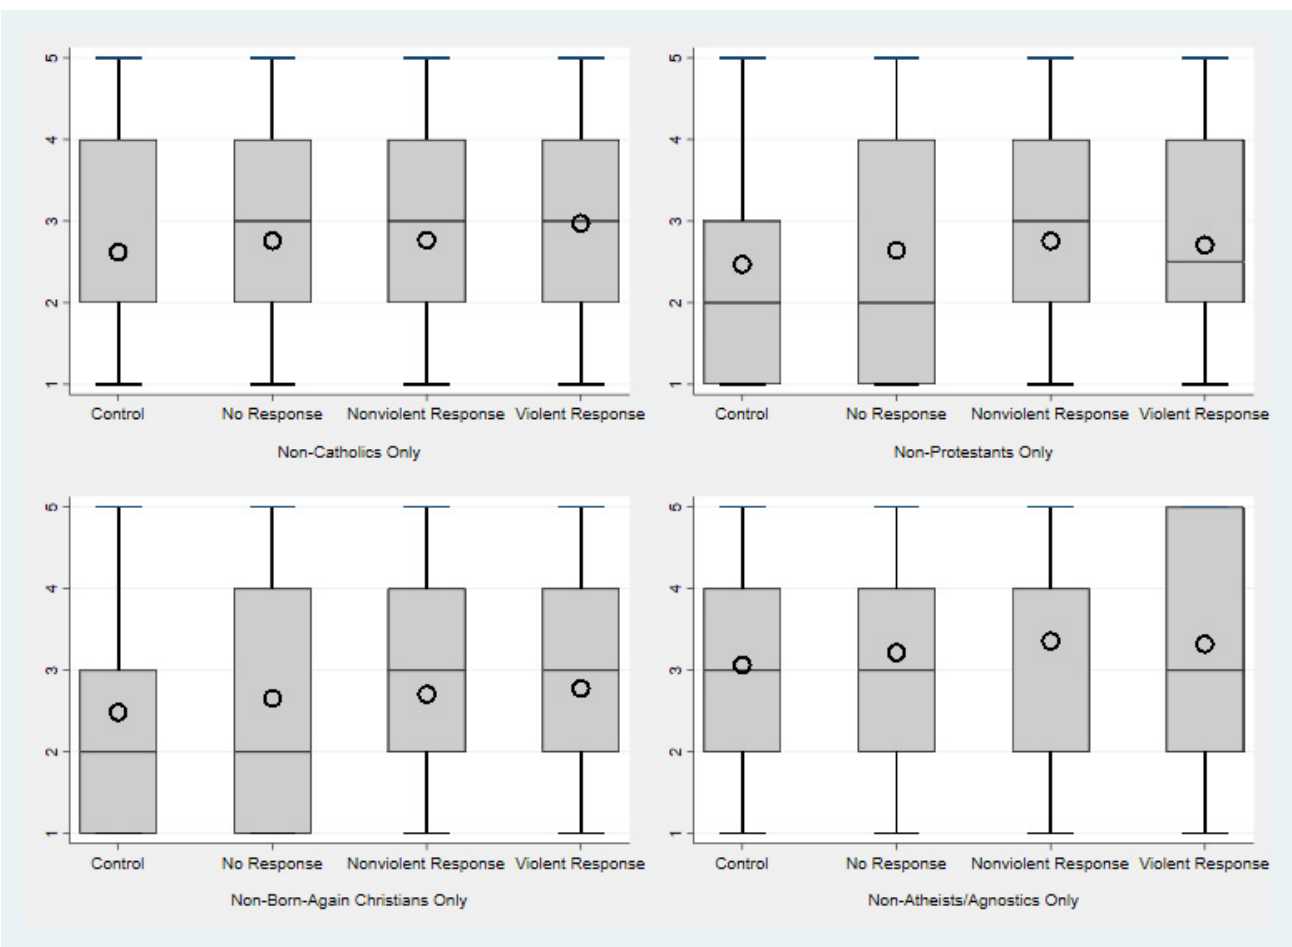
Figure A1. The causal effects of persecution discourse on perceptions of threat to religious liberty across conditions and by additional religious subsamples. The top left panel illustrates the effects of persecution discourse on the non-Catholic subsample’s perceptions of threat to religious liberty. The top right panel illustrates the effects of persecution discourse on the non-Protestant subsample’s perceptions of threat to religious liberty. The bottom left panel illustrates the effects of persecution discourse on the non-born-again Christian subsample’s perceptions of threat to religious liberty. For comparison, the bottom right panel illustrates the effects of persecution discourse on the non-Atheist and non-Agnostic subsample’s perceptions of threat to religious liberty.